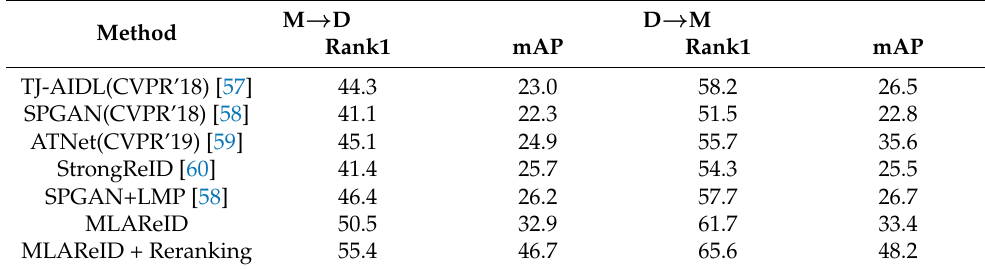
Table 3. Experiment results in cross-domain dataset.